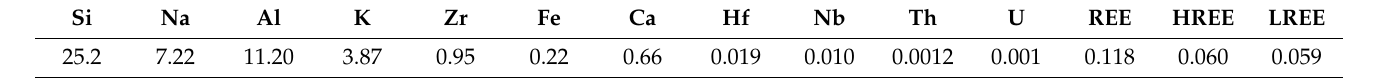
Table 4. Chemical components of interest of the non-magnetic fraction (in wt.%).